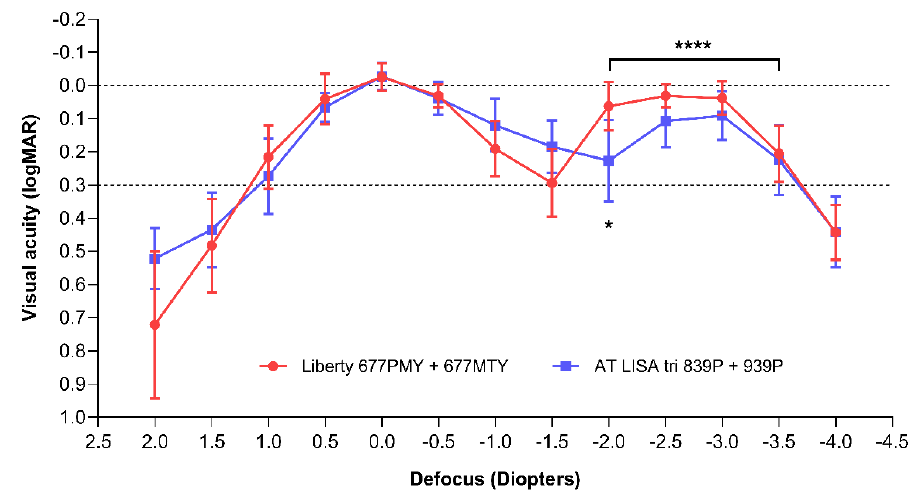
Figure 3. Monocular defocus curves of the two IOL models, plotted 12 months after surgery. Pairwise comparisons showed a significant difference only at the − 2.0 D defocus value (*), while the area under curve analysis confirmed superior near vision performance for the Liberty IOL ( p = 0.0004; ****).